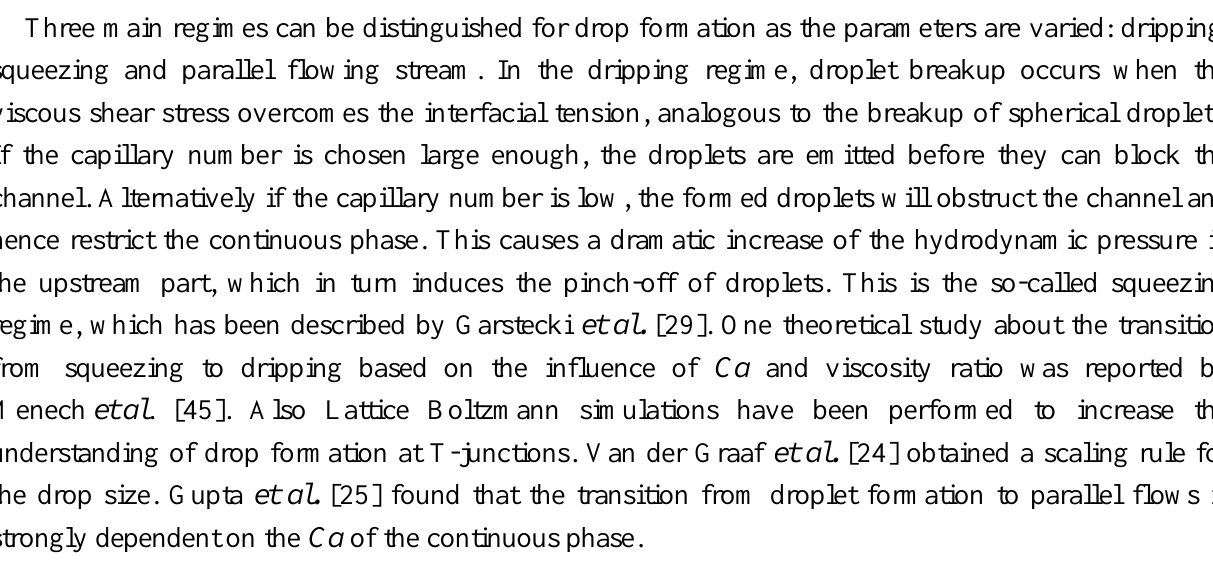
Figure 1. Droplet formation in a T-junction. The dispersed phase and continuous phase meet in a T-shaped junction perpendicularly. ( W